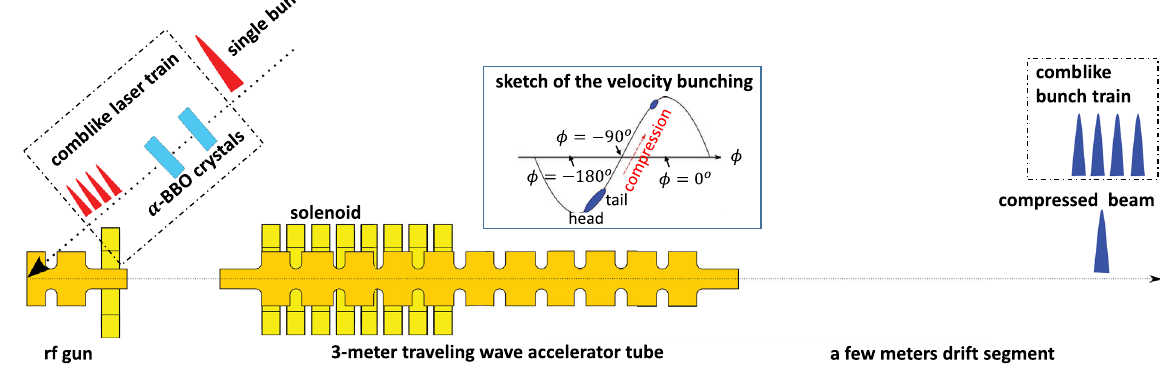
FIG. 1. Sketch of the velocity bunching scheme at the TTX beam